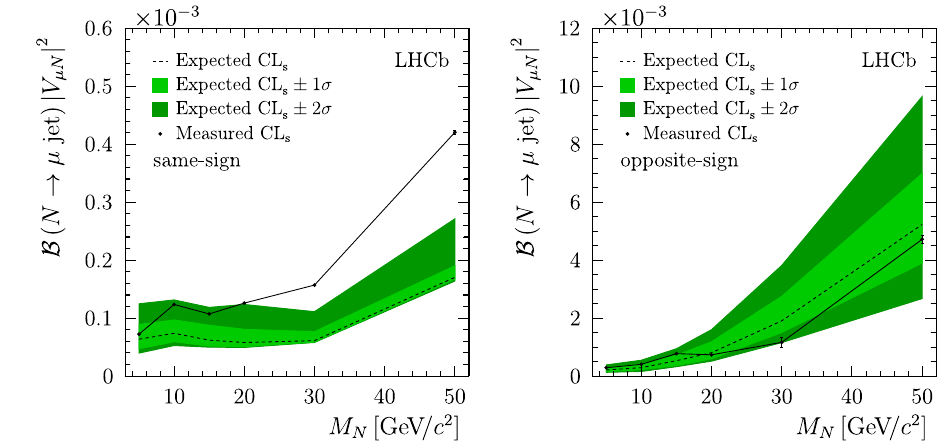
(cid:2) (cid:2) (cid:2) 2 (cid:2) V μ N